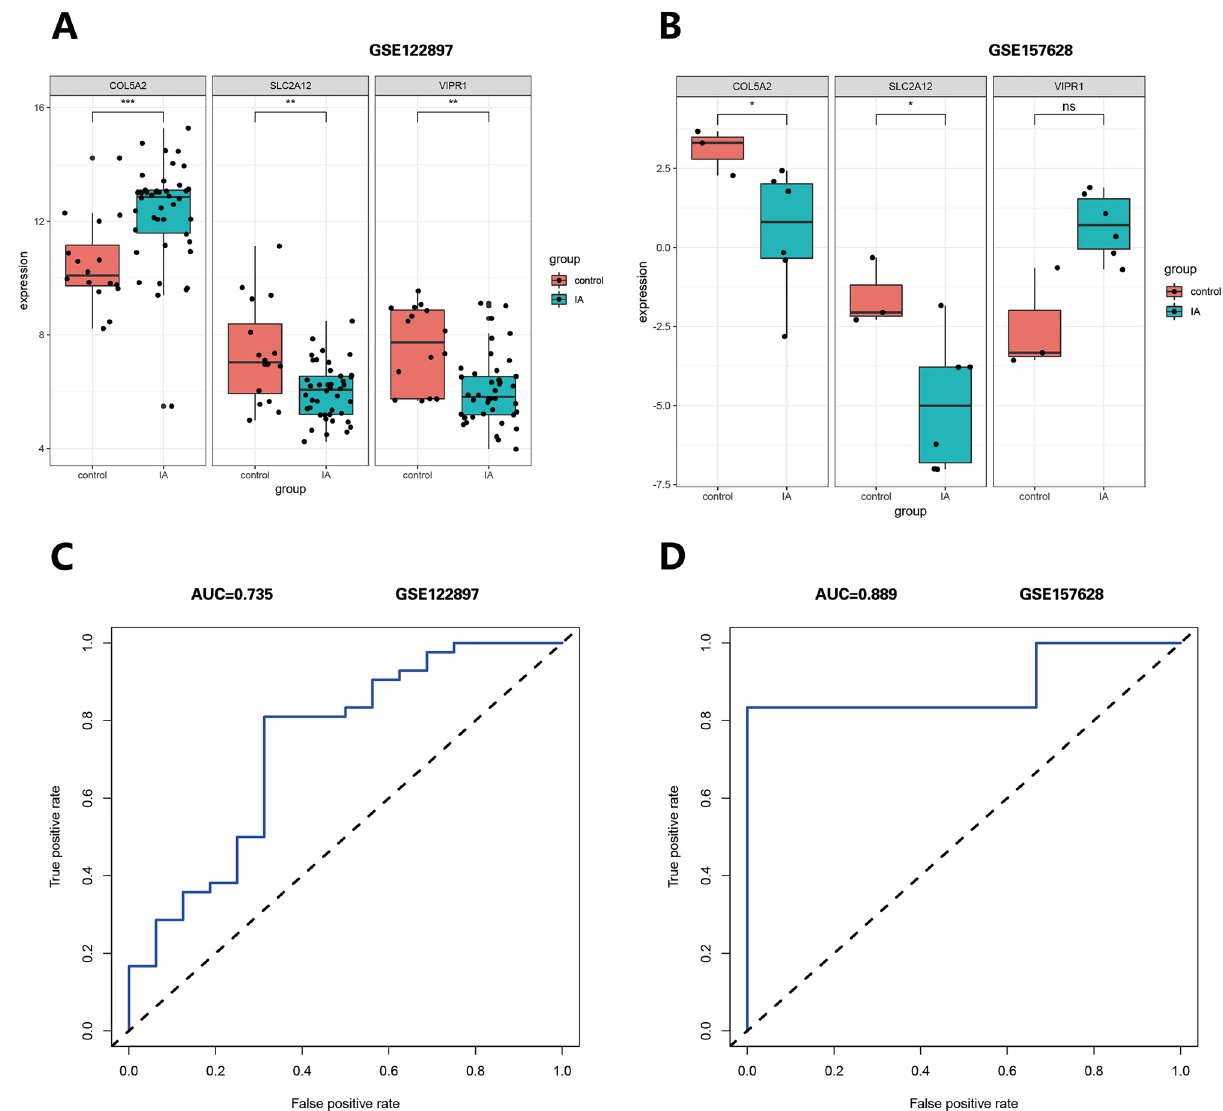
plot of SLC2A12 in GSE122897. ( D ) ROC plot of SLC2A12 in GSE157628. (ns = no significance, * P < 0.05, ** P < 0.01,*** P <